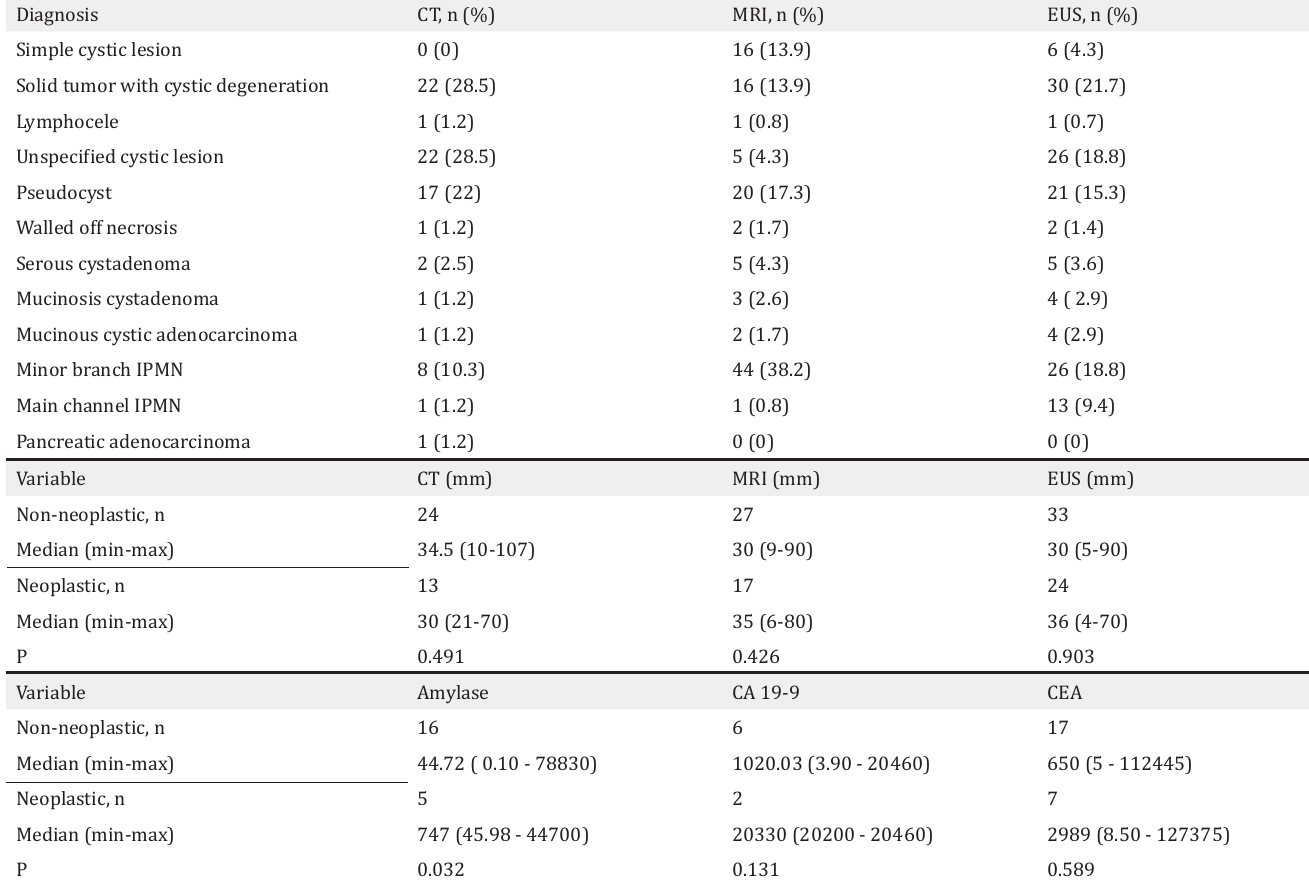
Radiological diagnoses, cyst diameters and cyst fluid biochemistry analysis detected in the